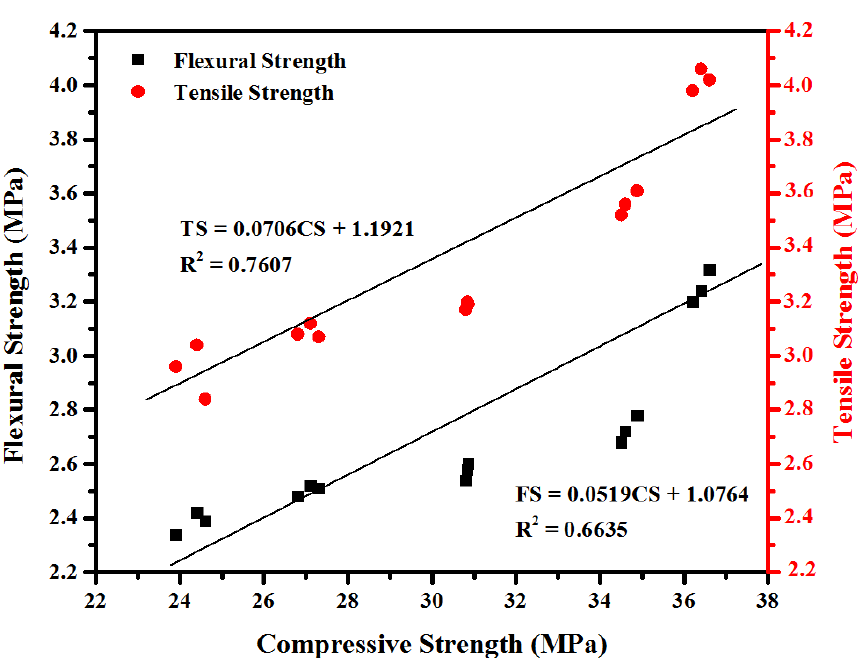
Figure 8. Correlation between mechanical properties of epoxy resin modified specimens.